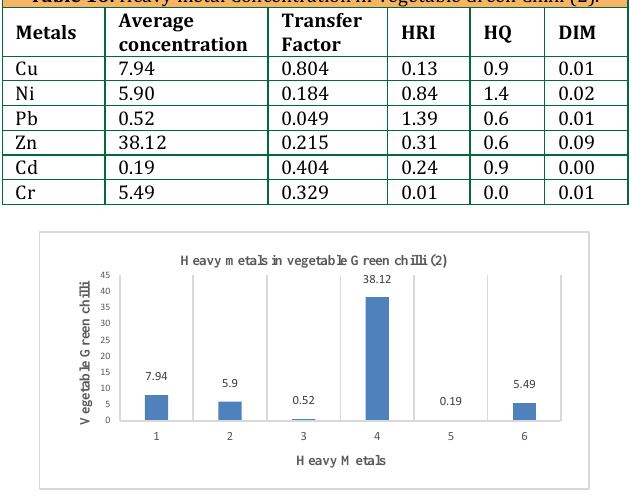
Figure 13: Average Concentration in vegetable Green chilli (2)